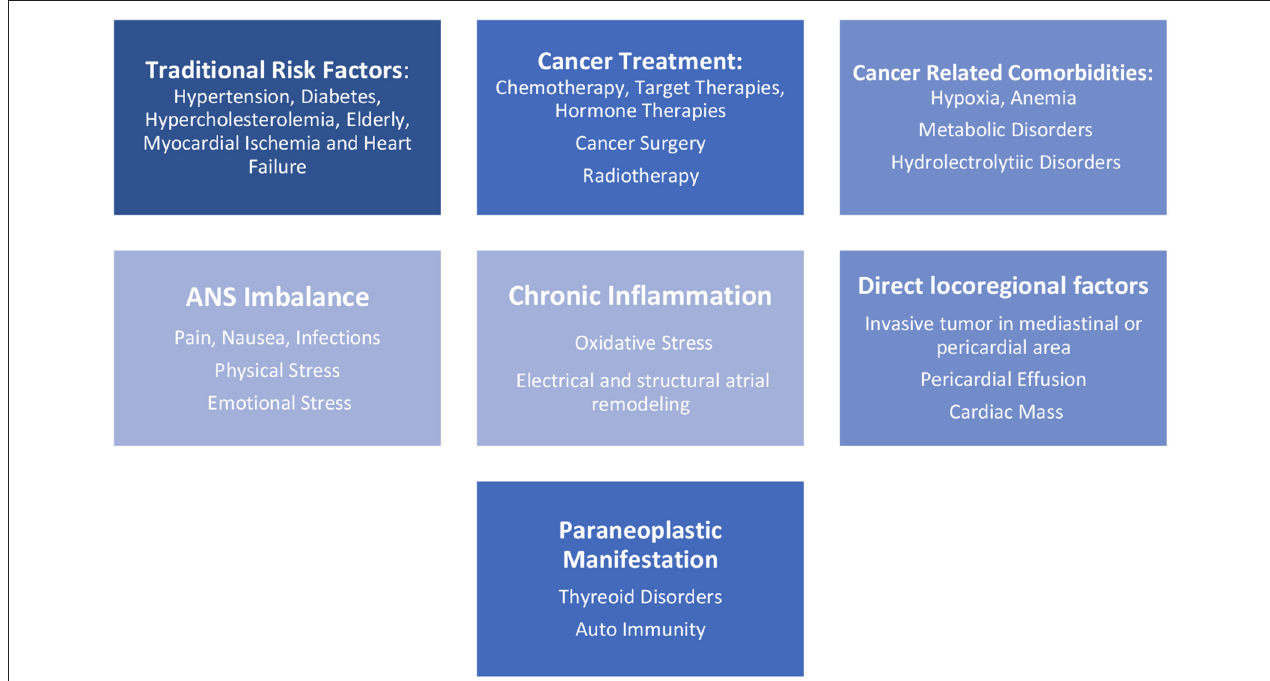
FIGURE 1 | Pathophysiology of AF in cancer patients.